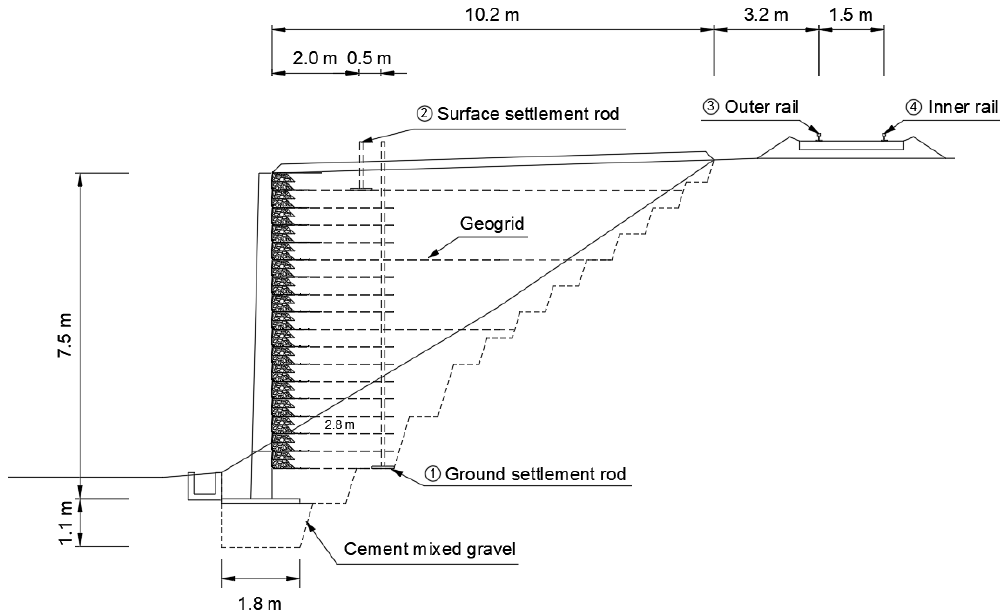
Figure 6. Section view of the RSR and measurement point.